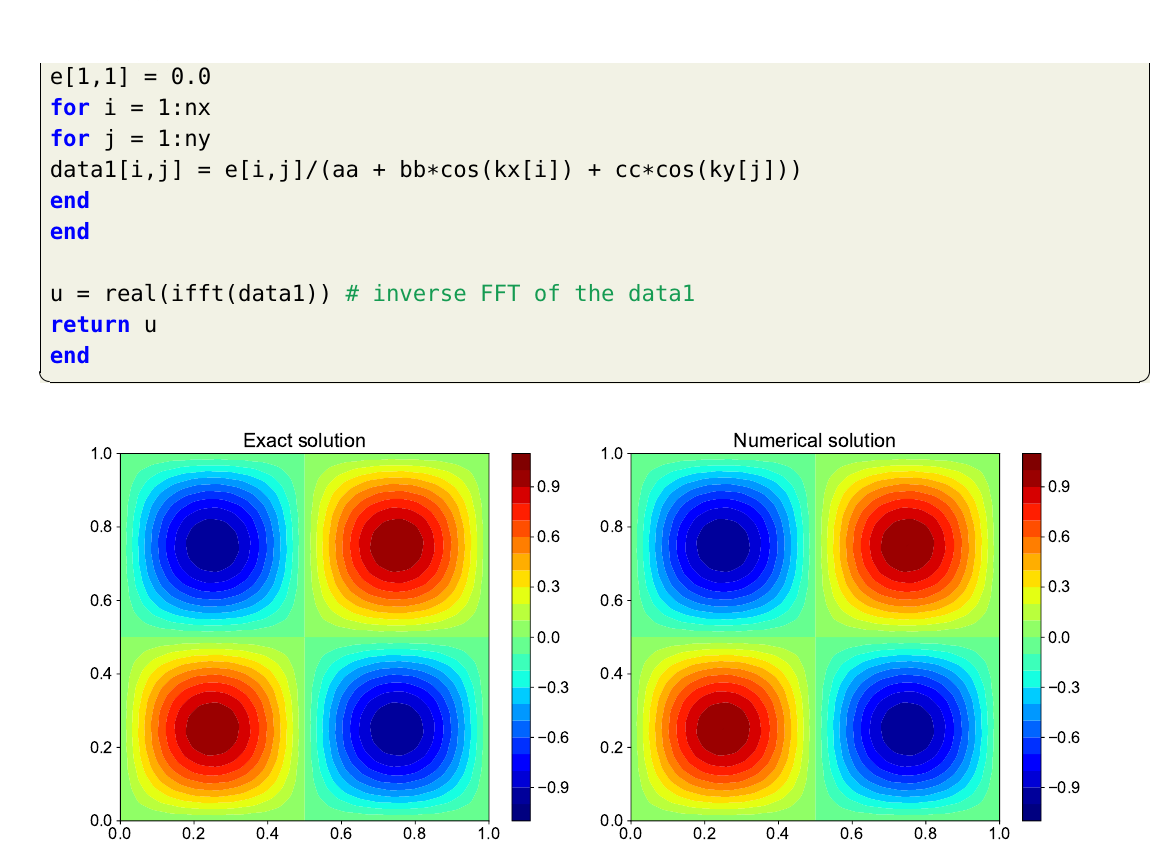
Figure 16. Comparison of exact solution and numerical solution computed using fast Fourier transform method for the Poisson equation with periodic boundary